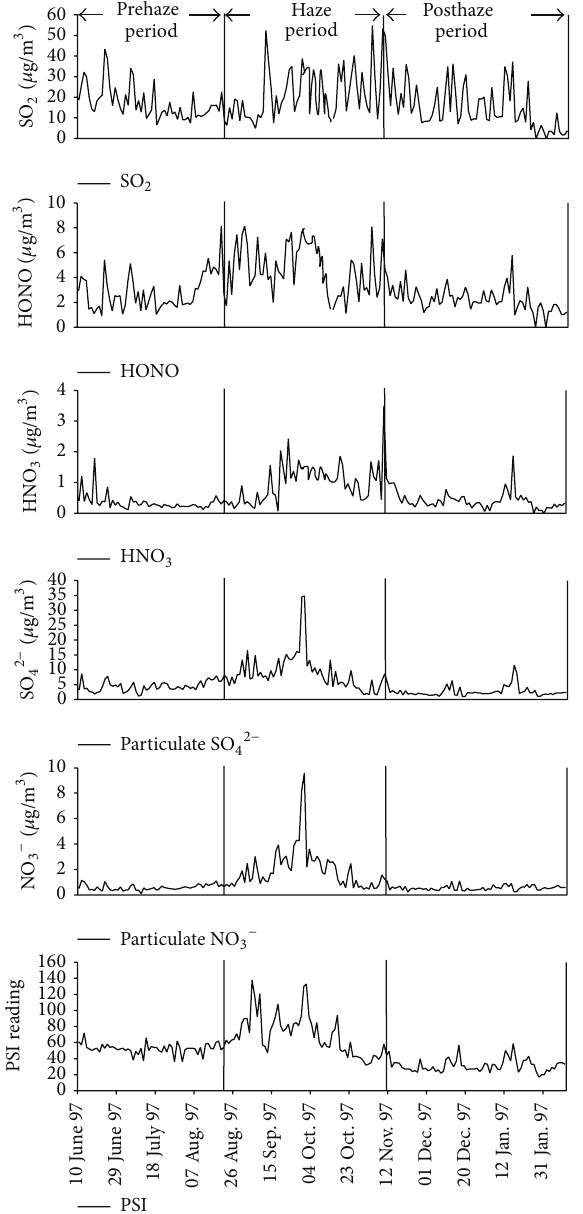
Figure 1: Time-series plots of daily concentrations of air pollutants along with PSI values during prehaze, haze, and posthaze